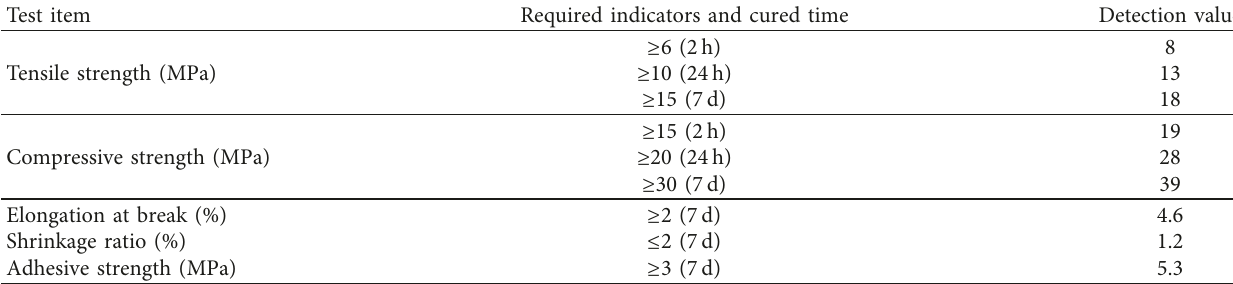
Table 3: The major mechanical properties of the cured materials.